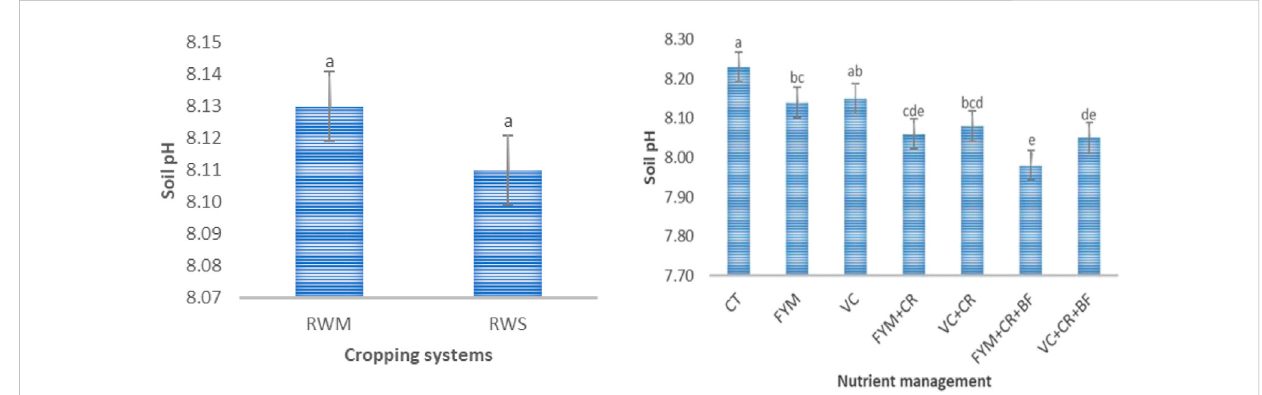
FIGURE 2 Long-term effectofcropping systemsandorganicnutrientmanagement onsoilpH.RWM:rice-wheat-mungbean;RWS:rice-wheat-sesbania;CT: control; FYM: farm yard manure; VC: vermicompost; CR: crop residue(s); and BF: biofertilizer(s). Statistical method: analysis of variance for strip-plot design in SAS 9.3 software; n = 42. Values with a different capital letter indicate a signi fi cant difference among the different treatments at p < 0.05 by the LSD test. Bars represent means ± SEM.